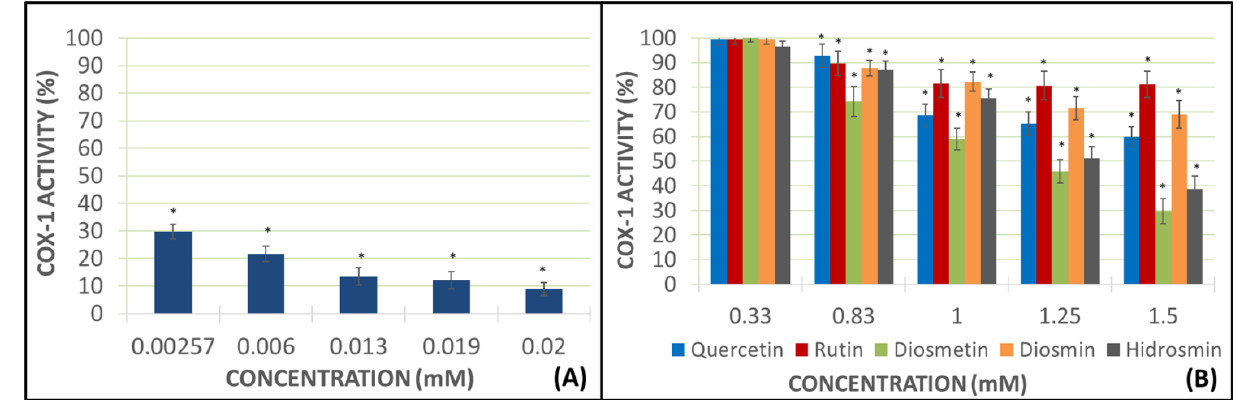
Figure 5. TXB 2 production is represented as COX-1 activity in the presence of indomethacin ( A ) and each flavonoid at different concentrations ( B ). Error bars indicate the standard deviation. Color bars describe the mean and standard devi- ation for N = 8. * p < 0.05: significant variations respecting the COX-1 activity in the presence or absence of the assayed